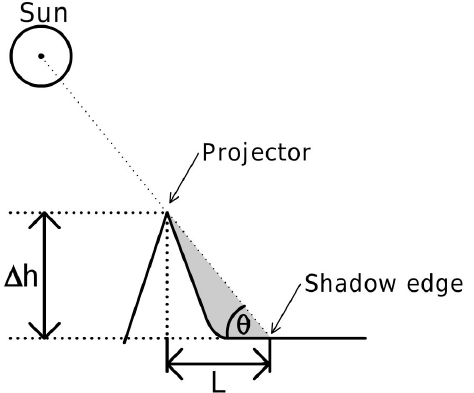
Figure 1. Geometric schematic of a simple height difference calculation using a shadow.